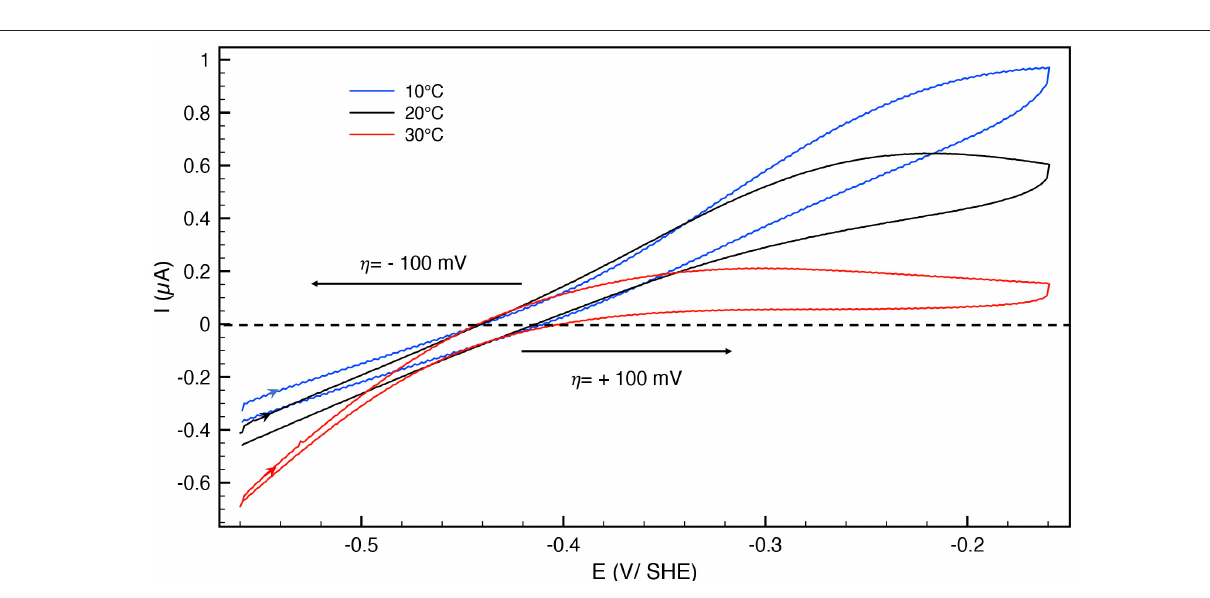
vs. SHE, 45% of the reduction current (i.e., enzyme activity) is lost, while the loss is only 30% after the third step (percentage